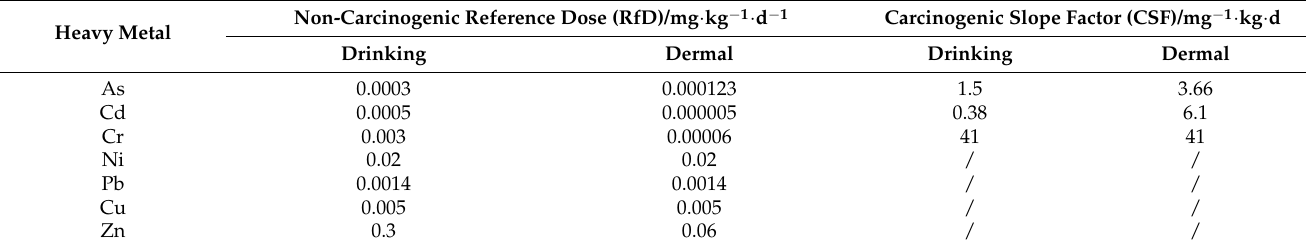
Table 2. Toxicological characteristic parameters of heavy metals